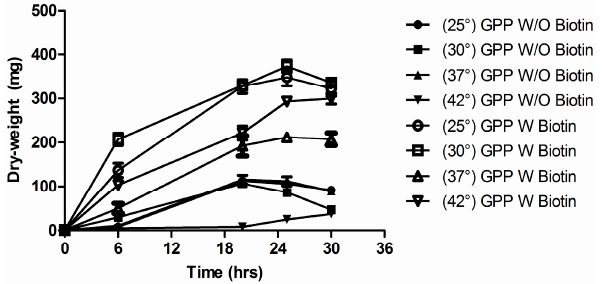
Figure 8. Lack of temperature dependence for the biotin auxotrophy. C. albicans SC5314 were grown for two cycles in GPP without biotin at 30 °C for 30 h and then washed three times. The graph shows cultures grown into GPP for another 30 h with or without the addition of biotin. Cultures were observed at different temperature, and plotted as (closed symbol—no addition of biotin): , 25 °C; , 30 °C; , 37 °C; ▼ , 42°C; (open symbol—with 100 nM biotin): ○ , 25 °C; □ , 30 °C; , 37 °C; , 42 °C. After two washes, dry weights of the cells were determined. Values shown are the average of triplicate experiments ± SD.